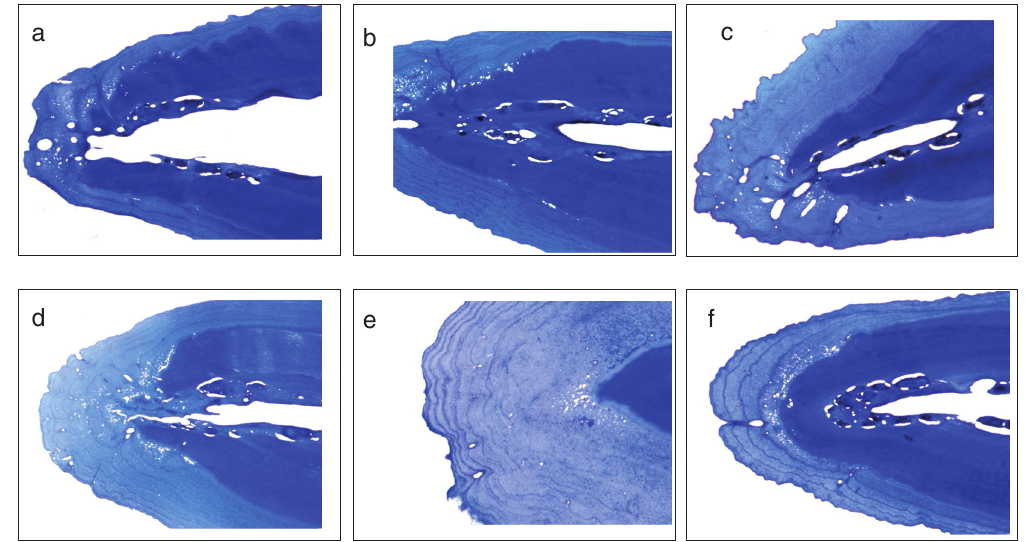
Fig. 7. Examples of different mineralization anomalies in harbour seal teeth. Stain used is Toluidine Blue. a) Seal K0774: pulp stones and cemental disturbance; b) Seal K0818: pulp stones; c) Seal K0908: “wobbly” cement on outside of tooth ; d) Seal K0965: cementum and dentine border hard to see at the pulp cavity opening; e) Seal K0968: paired laminae in older GLGs; f) Seal K0938: pulp stones and dentinal